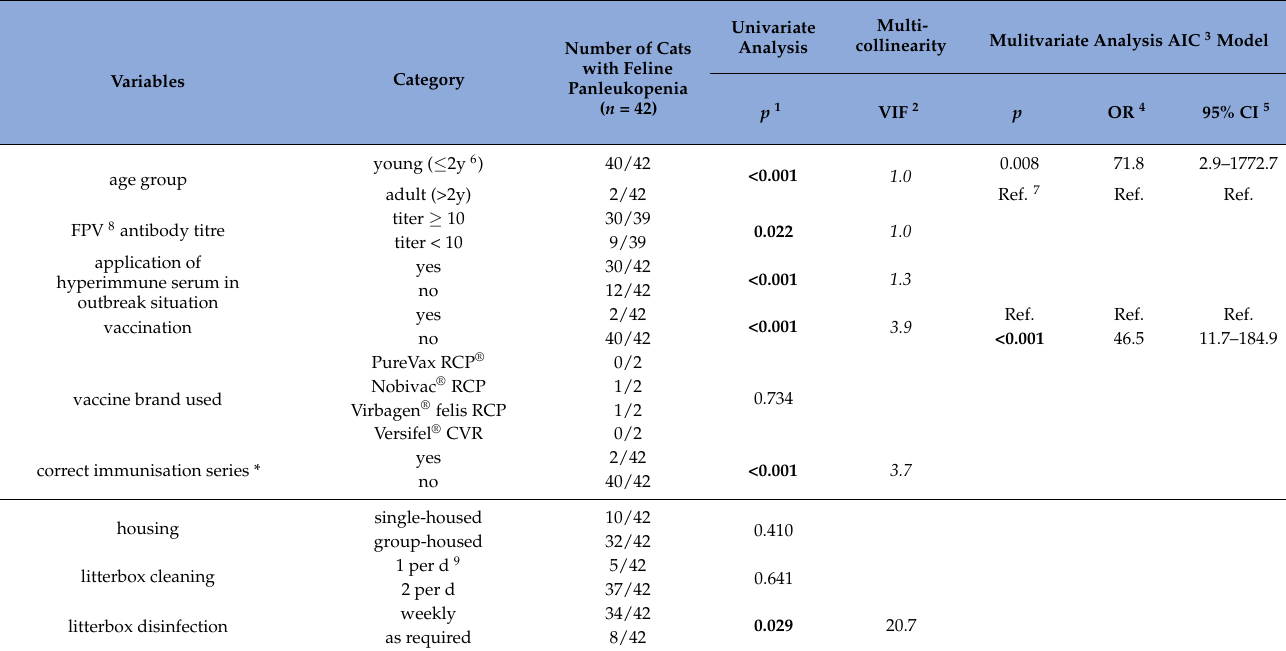
Table 2. Medical, husbandry, and hygiene risk factors associated with the presence of feline pan- leukopenia in uni- and multivariate